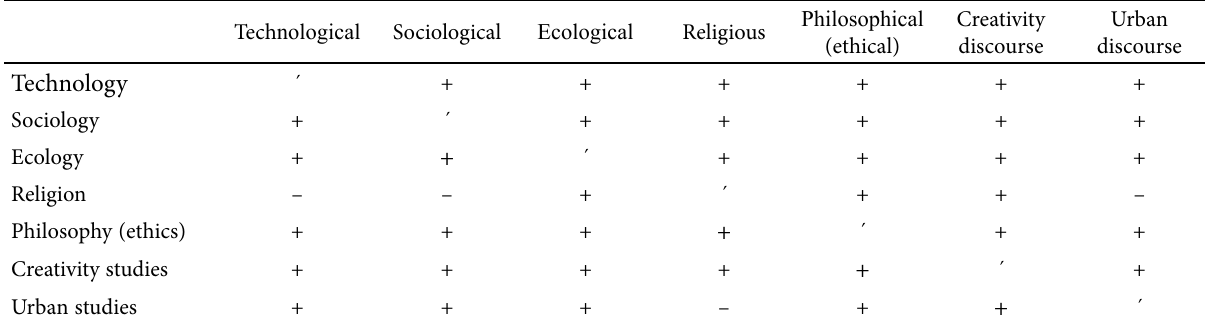
Table 1. Combinations of environmental